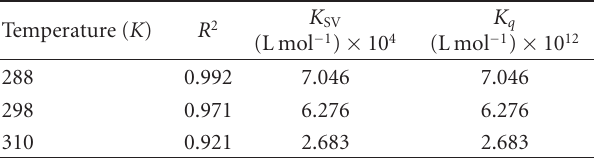
Table 1: The quenching constants of the Fe(III) complex by CT- DNA at di ff erent temperatures.